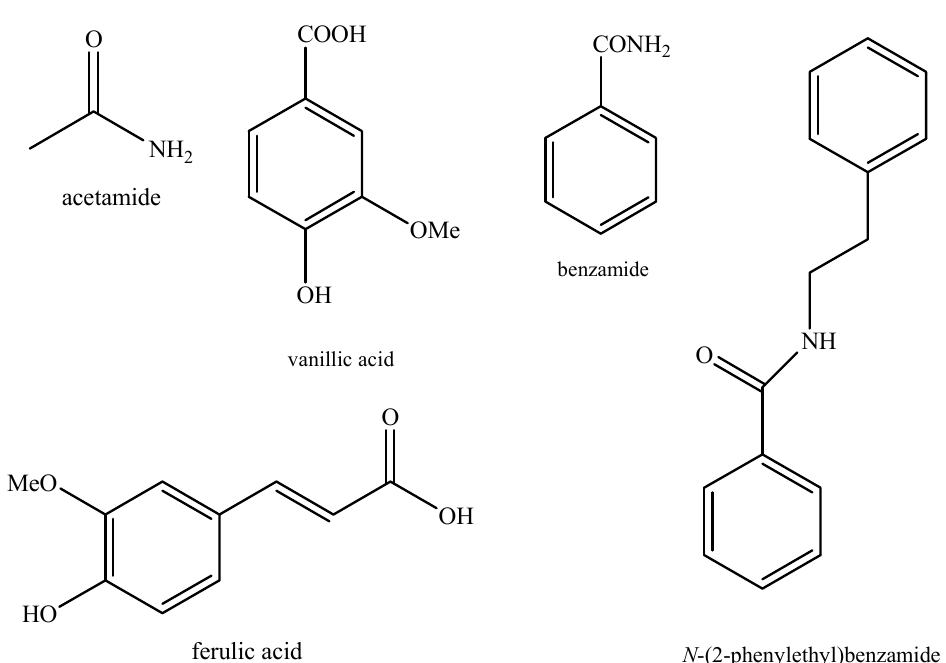
Figure 14. Structure of the other compounds identified in Haplophyllum species.